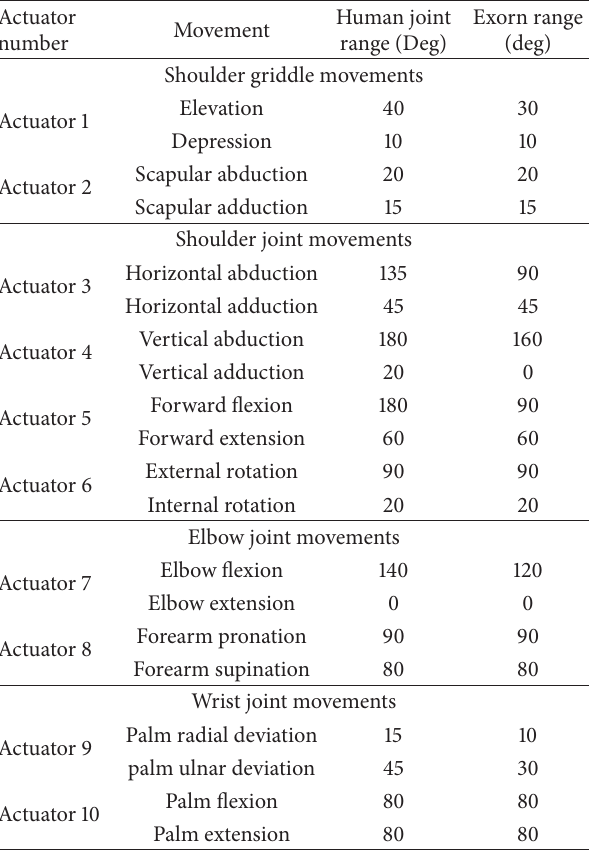
Table 1: Comparative study between joints of human arm and Exorn.